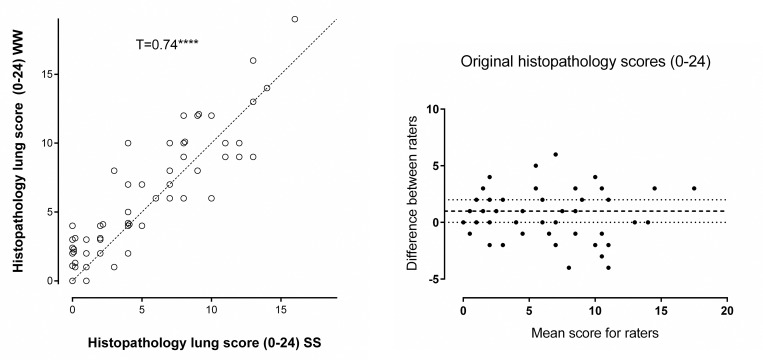
A. Scatter dot plot showing individual pulmonary histopathology scores for lung samples using the original scoring system (max 24 points). WW vs. SS, Kendall rank order coefficient T = 0.74, z = 8.54, p≤0.00003. NB some similar values that overlapped have been nudged so that the data points can be seen. B. Bland-Altman analysis of the original scoring system WW vs. SS, difference (WW-SS) vs. mean. The dotted lines show the Inter Quarter (IQ) range.